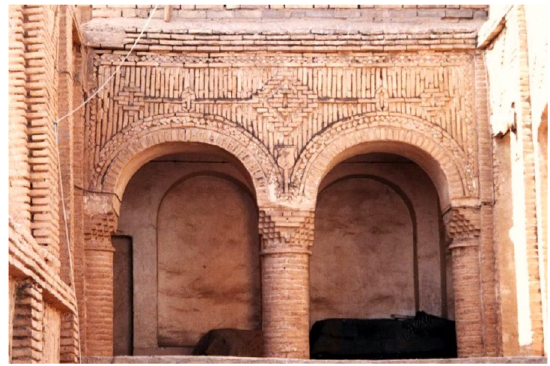
Fig. 8 Sham-Gol-Andaz Xowun in Shayegan house. Source: MCHT of Dezful